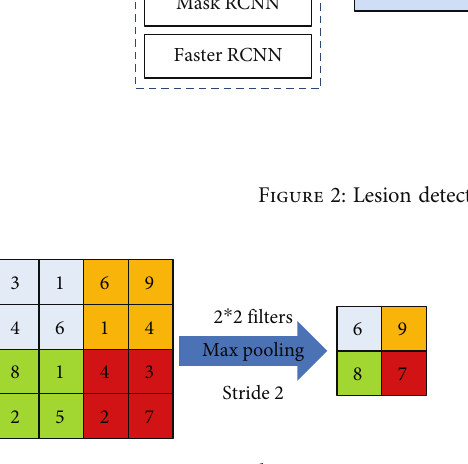
Figure 3: Maximum pooling